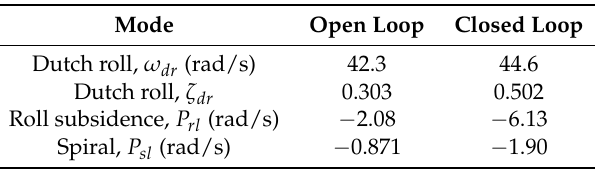
Table 13. Open loop and closed loop lateral modes of